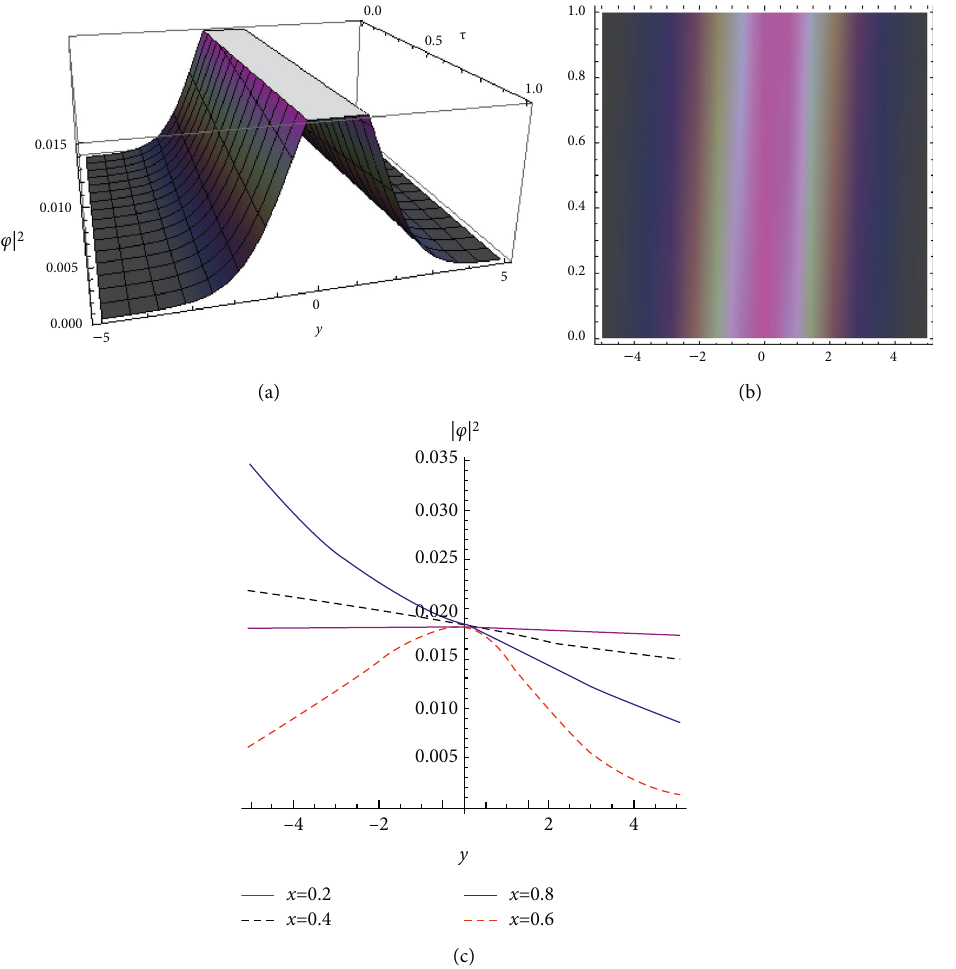
Figure 2: In these figures, we take ς solution | φ | 2 , (a) displays the 3D-plot of | φ | 2 with χ � 1, (b) displays the density plot of the solution | φ | 2 , and (c) displays the 2D-plot of | φ | 2 with different values of χ